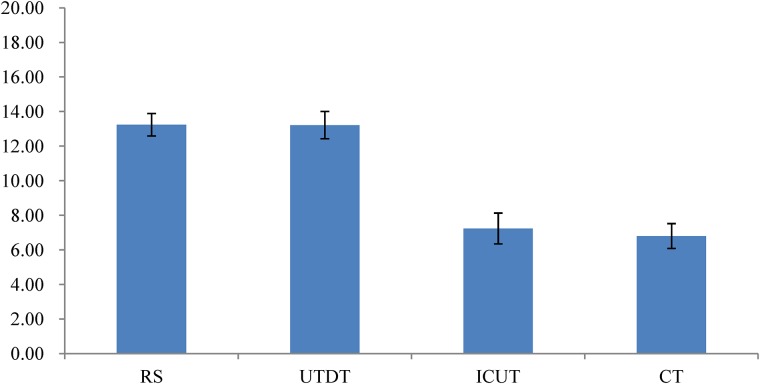
The mean of the differential attitude scores under different thinking modes in Experiment 2. Higher scores indicate larger attitude scores. Error bars indicate the SE of the differential attitude scores.